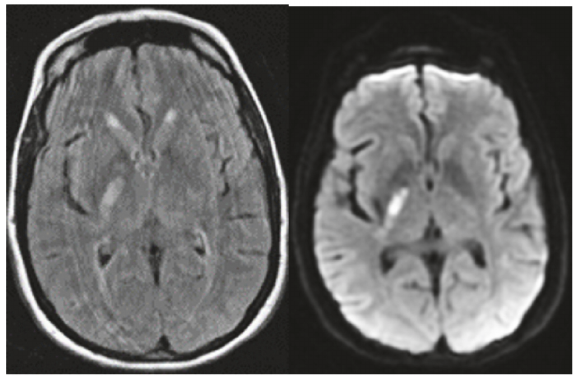
Figure 1: T2 FLAIR and DWI on initial